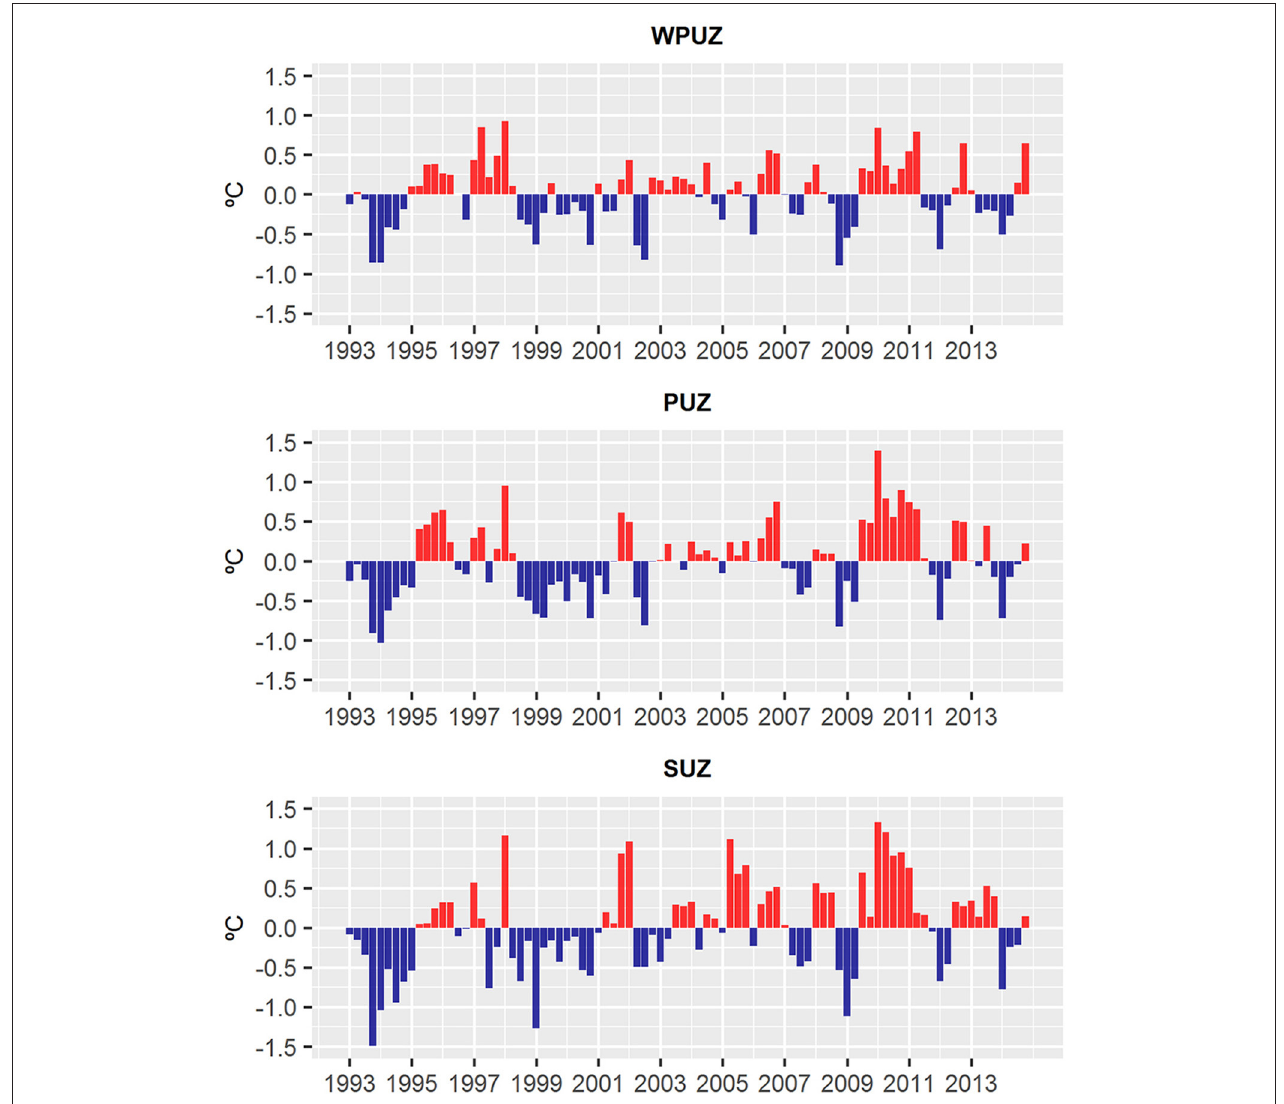
FIGURE 8 | Seasonal SST climatological anomalies in each upwelling zone for the 1993–2014